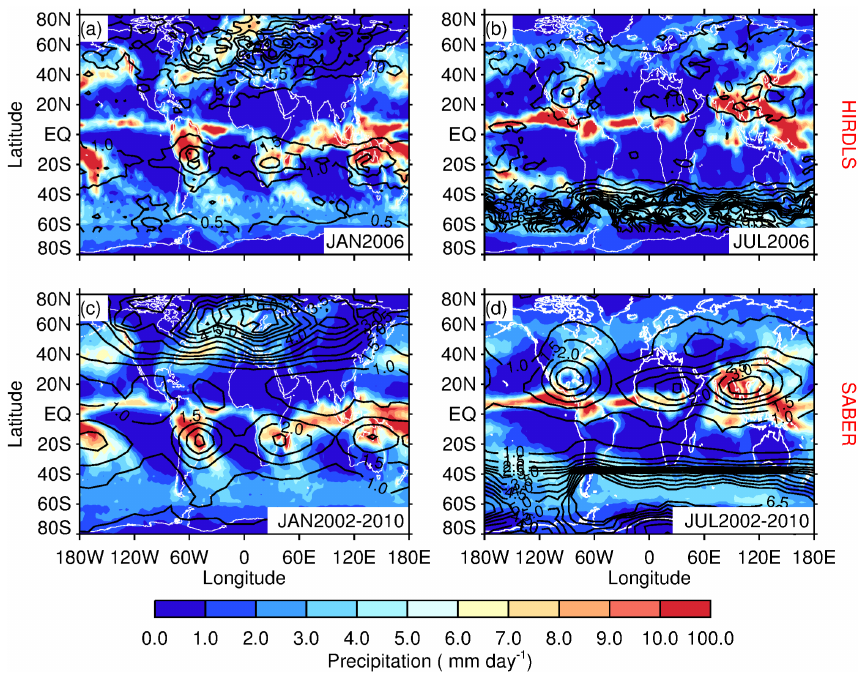
Figure A2. Global distribution of precipitation (colored, mmday − 1 ) and GWMF (contour lines, mPa) at 25km from HIRDLS (upper panels, year 2006) and SABER (lower panels, averaged from 2002 to 2010) in January (left column) and July (right column).